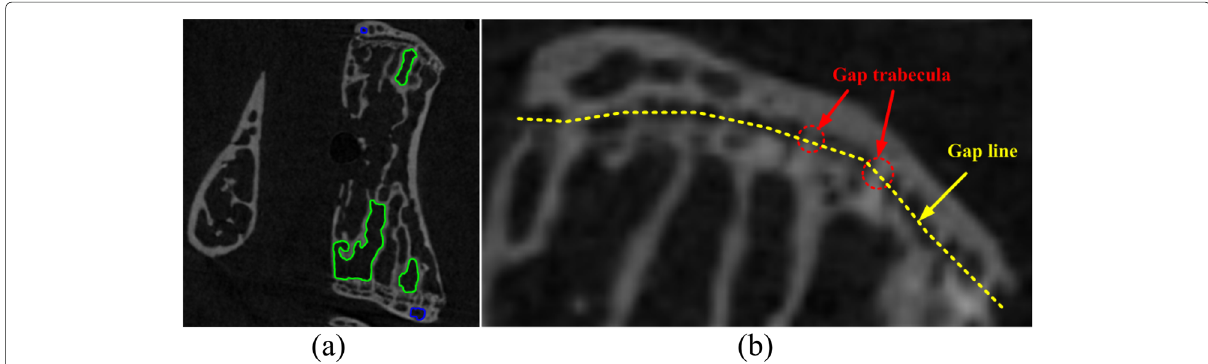
Fig. 1 Demonstration of endplate segmentation difficulties. a A sagittal view of the micro-CT data, where the blue and green marked the spongy structure caused by the cancellous bone. b Zoom in view of the endplate and its adjacent vertebral body region, where two of the gap trabecular and the gap line are labeled in red and yellow